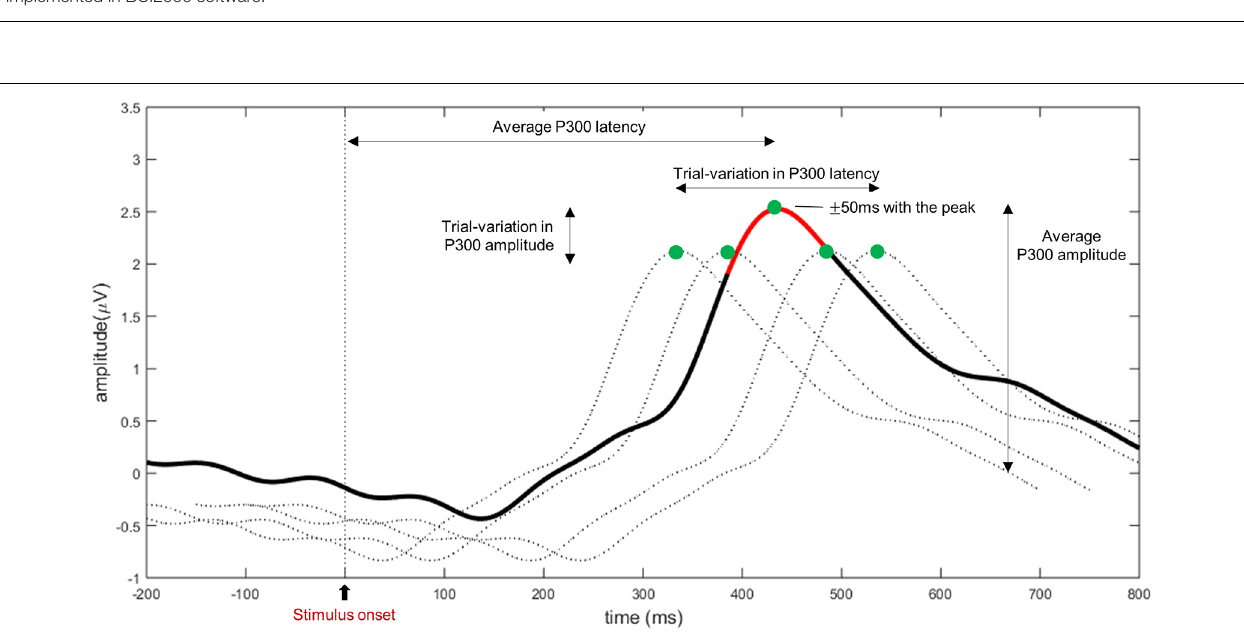
FIGURE 1 | Rapid serial visual presentation (RSVP) and P300 speller application. (A) RSVP paradigm. All subjects were instructed to focus on a green character (target) in a white-character stream and enter the target character using the keyboard during a total of 40 trials. (B) The conventional 6 × 6 matrix speller was implemented in BCI2000 software.